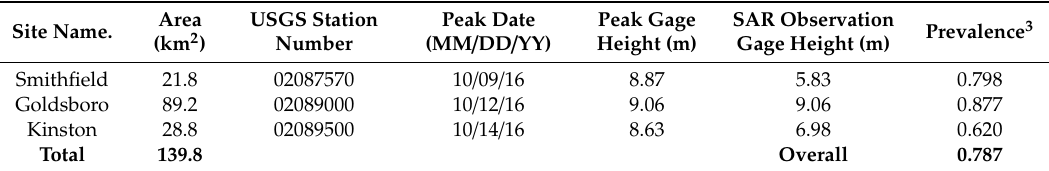
Figure 1. Neuse River Basin located within North Carolina ( a ) containing the three study sites Smithfield ( b ), Goldsboro ( c ), and Kinston ( d ). Each study site illustrates the high-water marks (HWM) collected by the United States geological survey (USGS), as well as the location of the USGS station. These data points were used to create the inundated areas within the study area boundaries. Table 1. Summary statistics and information for the three study areas with validation data furnished by the United States geological survey (USGS). Synthetic aperture radar (SAR). Observation occurred October 12th, 2016 at 11:15 UTC 1 (06:15 EDT 2 ).